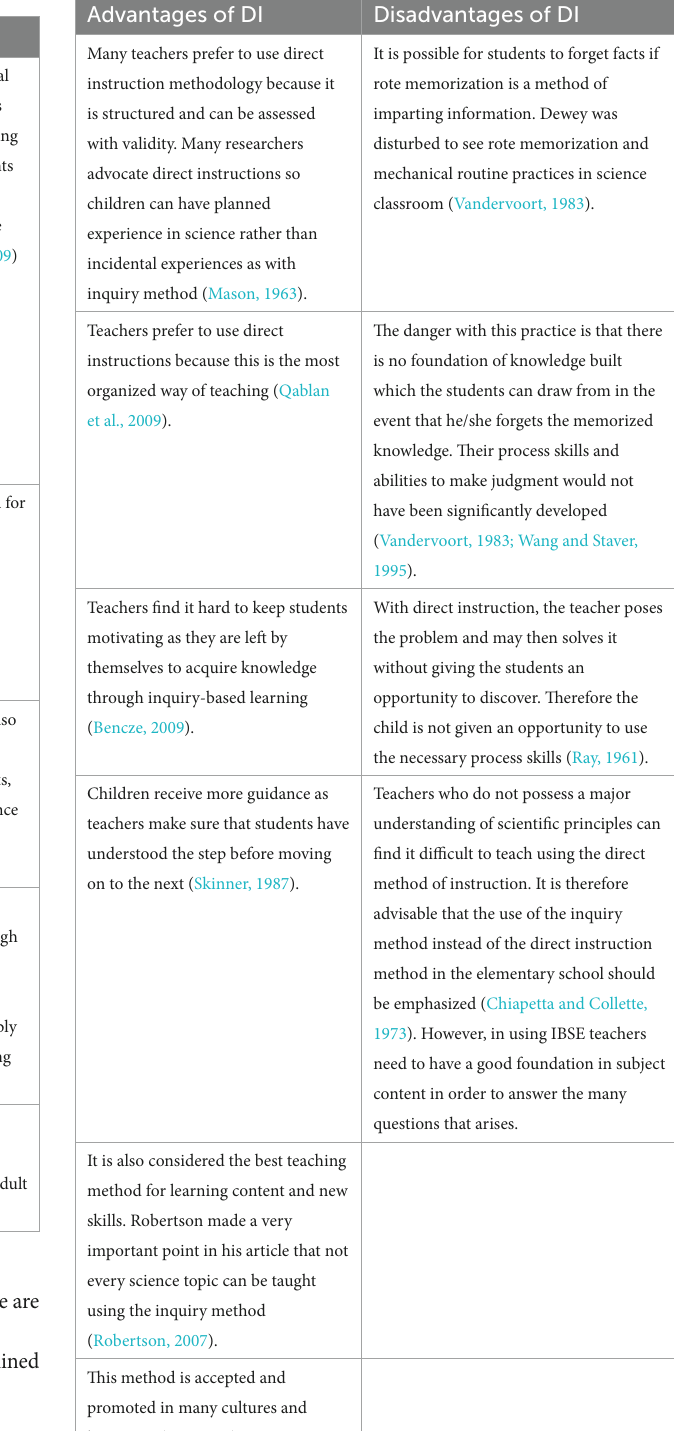
TABLE 2 Advantages and disadvantages of inquiry based science education